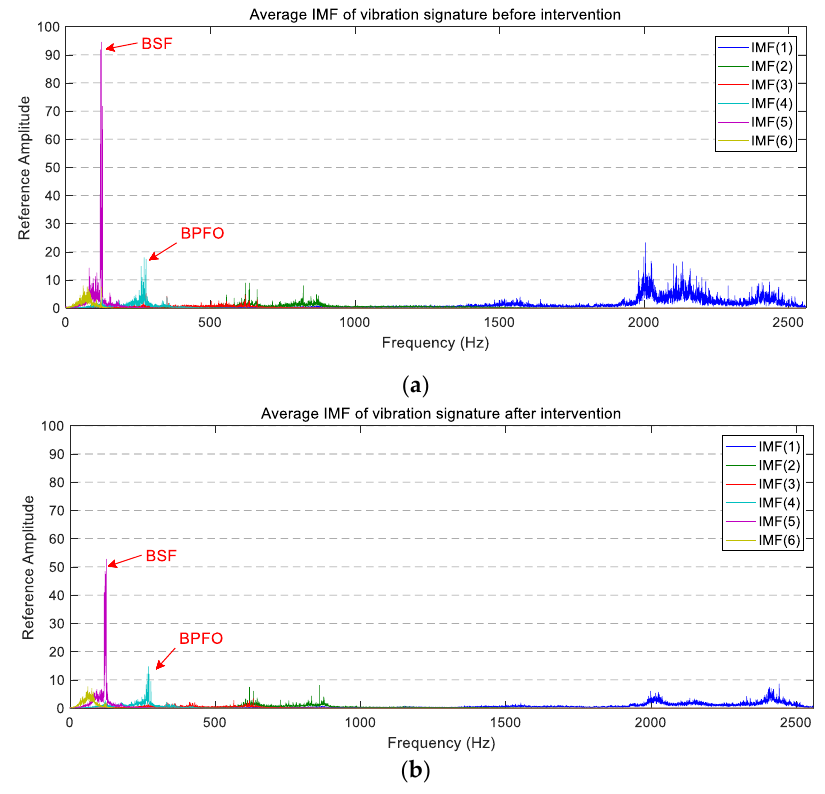
Figure 9. The average PSD of the IMFs corresponding to the vertical vibration signals: ( a ) before maintenance; ( b ) after maintenance.